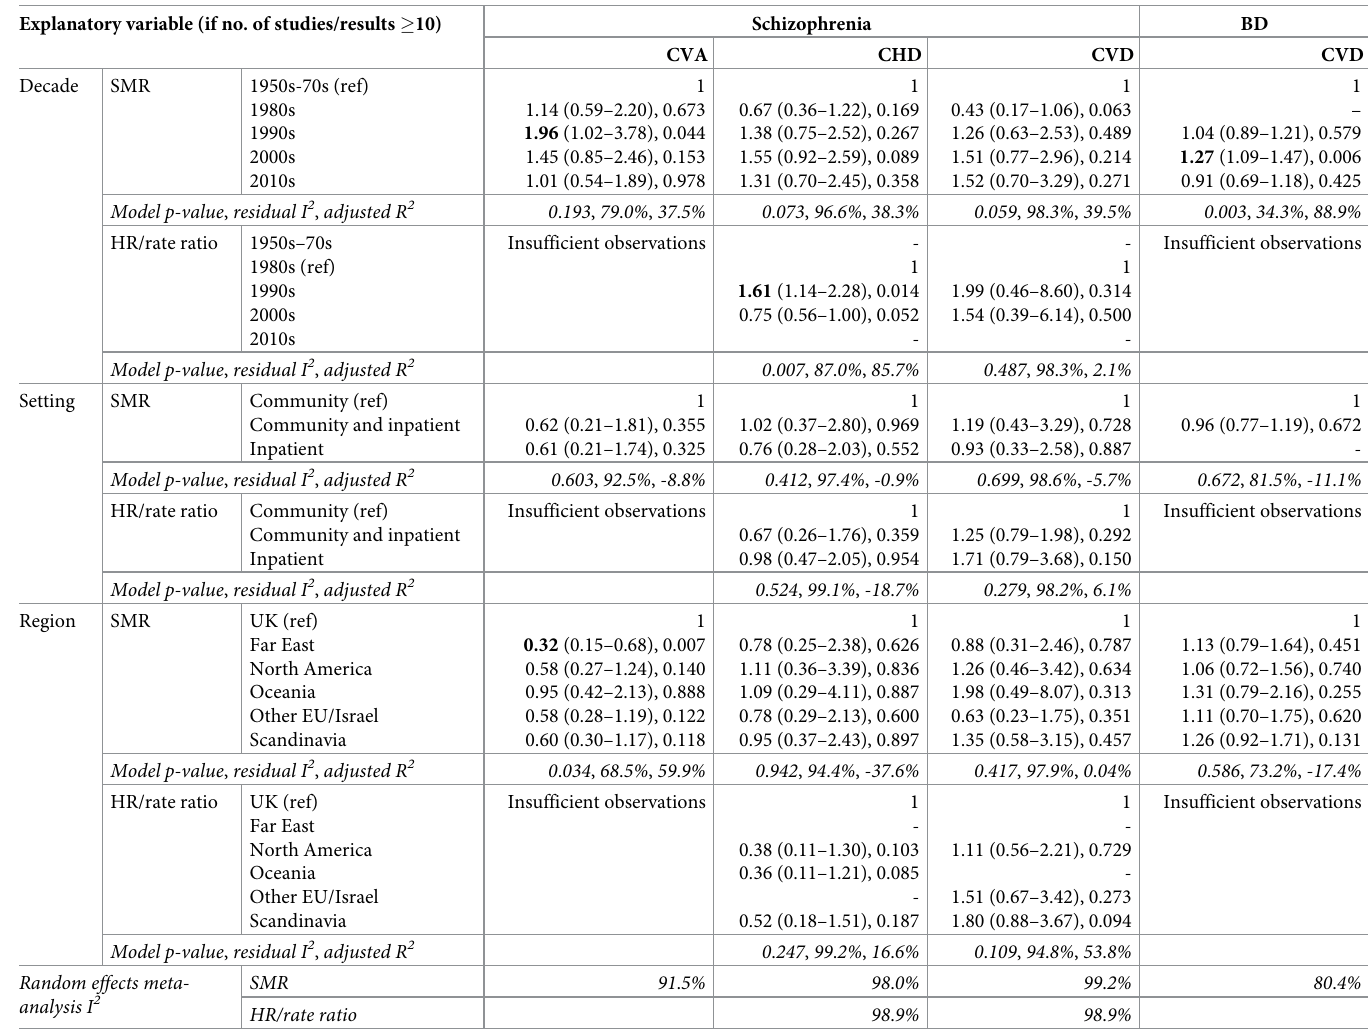
Table 3. Results of meta-regressions: estimates of increased risk relative to the reference category for study-level explanatory variables; exponentiated regression coefficients (95% CIs), p